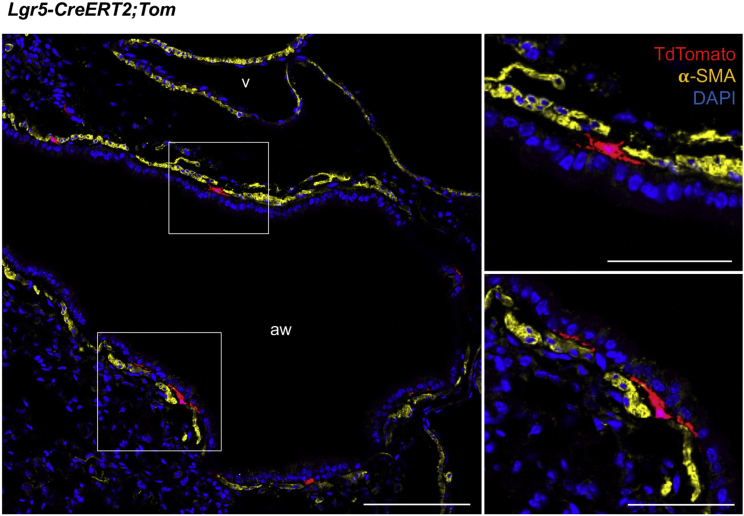
Lgr5 Marks Mesenchymal Lineages around Conducting Airways, Related to Figure 1Representative confocal images showing expression of Lgr5 in mesenchymal cells around airway epithelium in adult distal lungs: Tdtomato (for Lgr5, red), α-SMA (yellow), and DAPI (blue) in lung tissue sections from Lgr5-CreERT2;R26-Tom mice, following by Tamoxifen injection (Tmx, 0.2mg/g x 4). Scale bars, low magnification 200um; high magnification 50um.